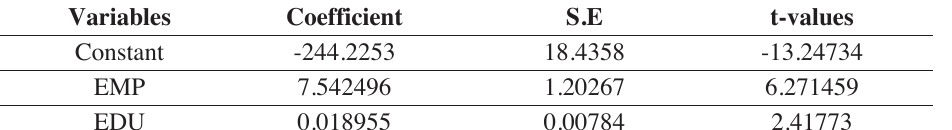
Table 6: Normalized equation of co-integration